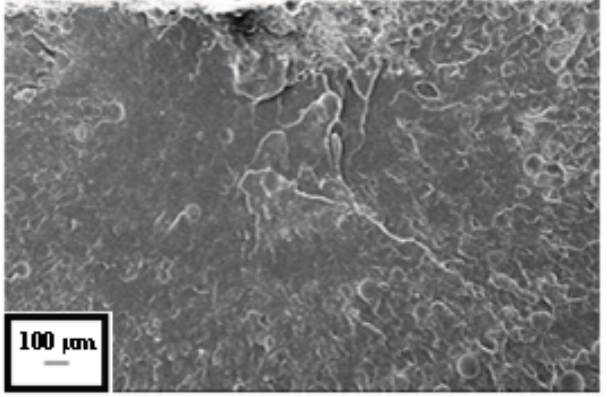
Figure 4. SEM micrograph of transition zone in